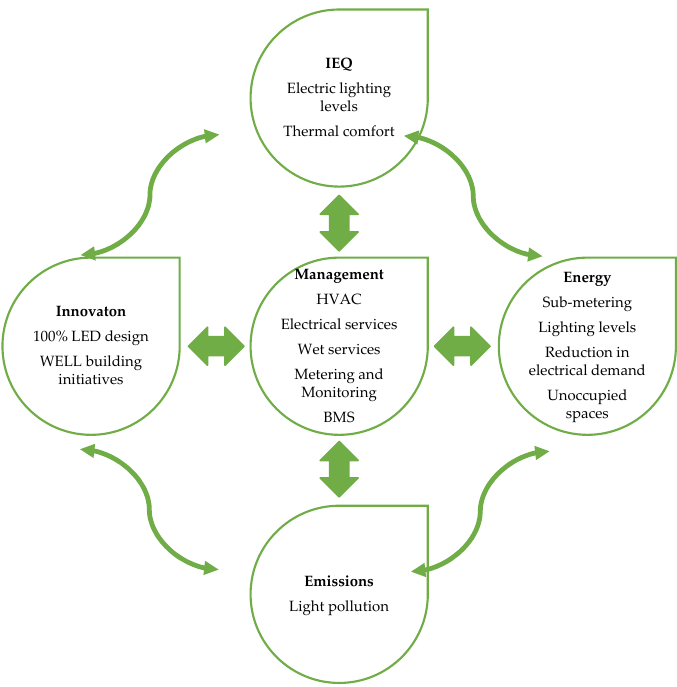
Figure 3. Simplified framework of dynamic relationship between variables.